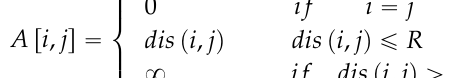
Figure 1. Illustration of ( a ) sink queries MWSN; ( b ) graphic description of MWSN.